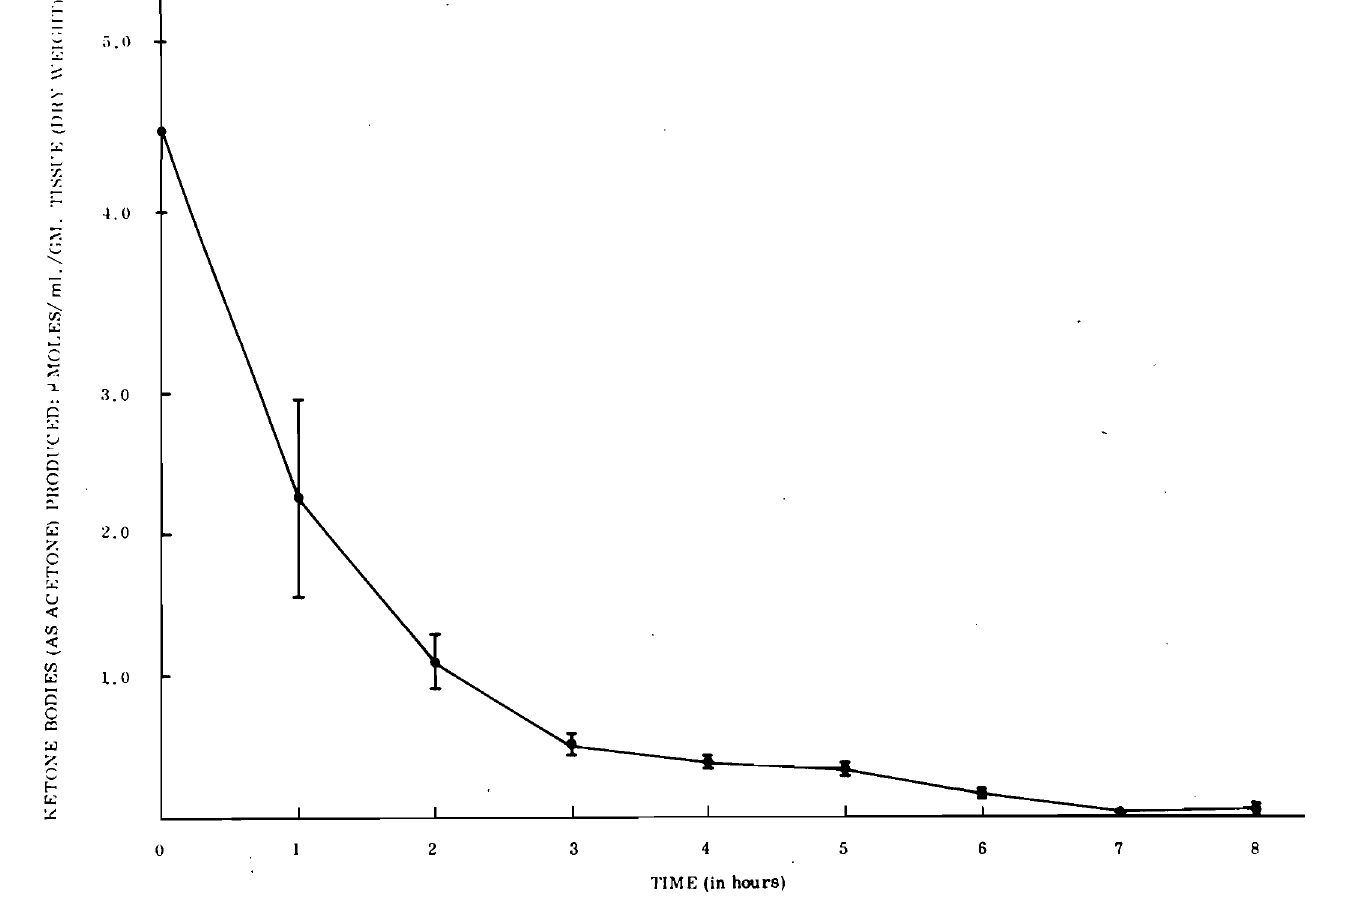
Fig. 3. Total Ketone Bodies (as acetone) produced by isolated ruminal epithelium as a function of time. N= f*